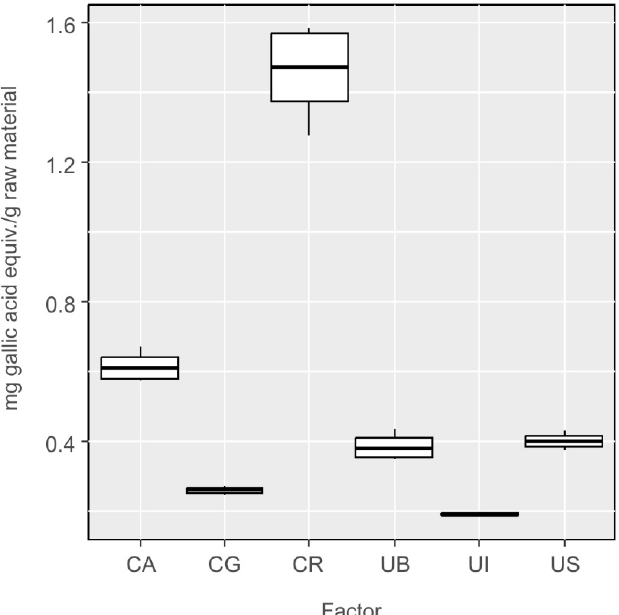
Figure 8. Results of determination of the content of polyphenols in extracts from Cladophora and Ulva species using the Folin–Ciocalteu method, converted into milligram equivalents of gallic acid per gram of raw material.